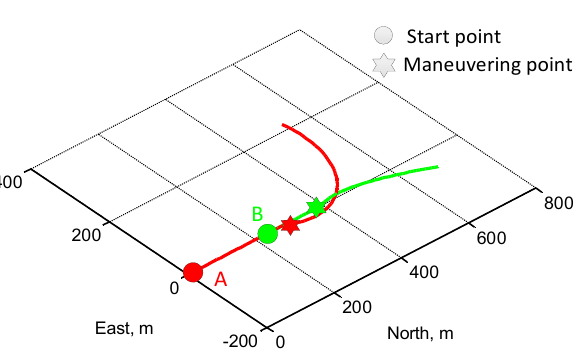
Figure 6. 3D flight path.